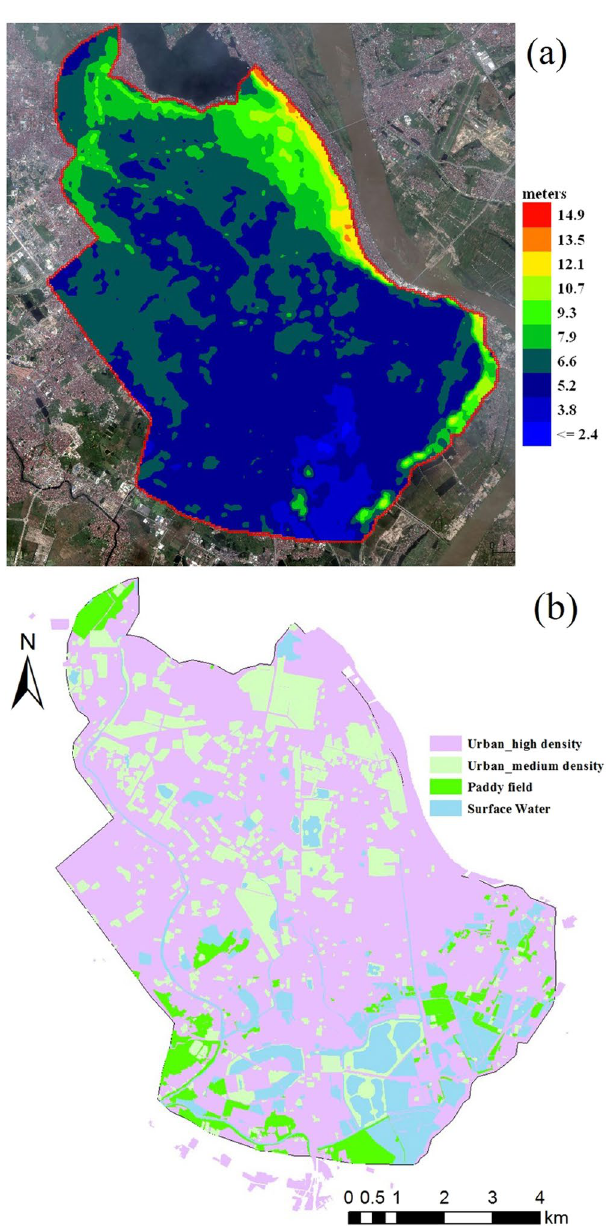
Figure 2. DEM map ( a ) (made by Flo-2D Pro, www.flo-2d.com) and Land use map ( b ) (made by ArcMap 10.2, www.esri.com)of Hanoi central area (Source: DEM data is modified from the 30 meter DEM data of USGS, background image map is obtained from the open source of Google Earth which data is from SIO, NOAA, U.S. Navy, NGA, GEBCO and image copyright belongs to 2012 Google. Land use map is drawn by Han Xue, the original land use data is provided by Kha Dang-Dinh).